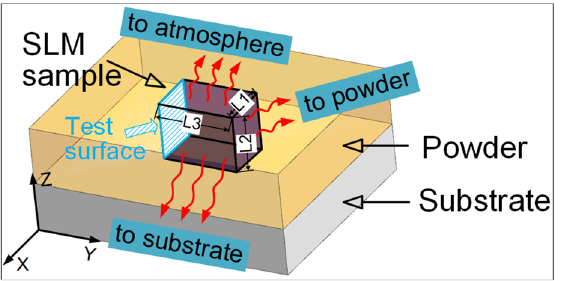
Figure 1. Schematic diagram of heat transfer during sample manufacturing ( L 3 > L 2 > L 1).